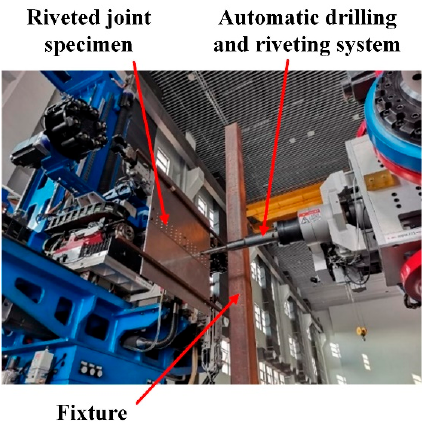
Figure 18. The riveted joints specimen production by automatic drilling and riveting system.